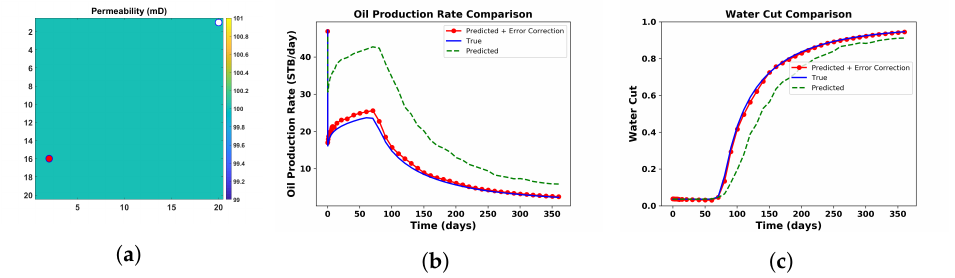
Figure 24. ( a ) Test case with a producer well location at (3,16). ( b ) Comparison of the oil production rate and ( c ) comparison of water cut, predicted using the global PMOR method alone (dotted green line) and after the implementation of the error correction model (red circled line) with the true solution (blue line).